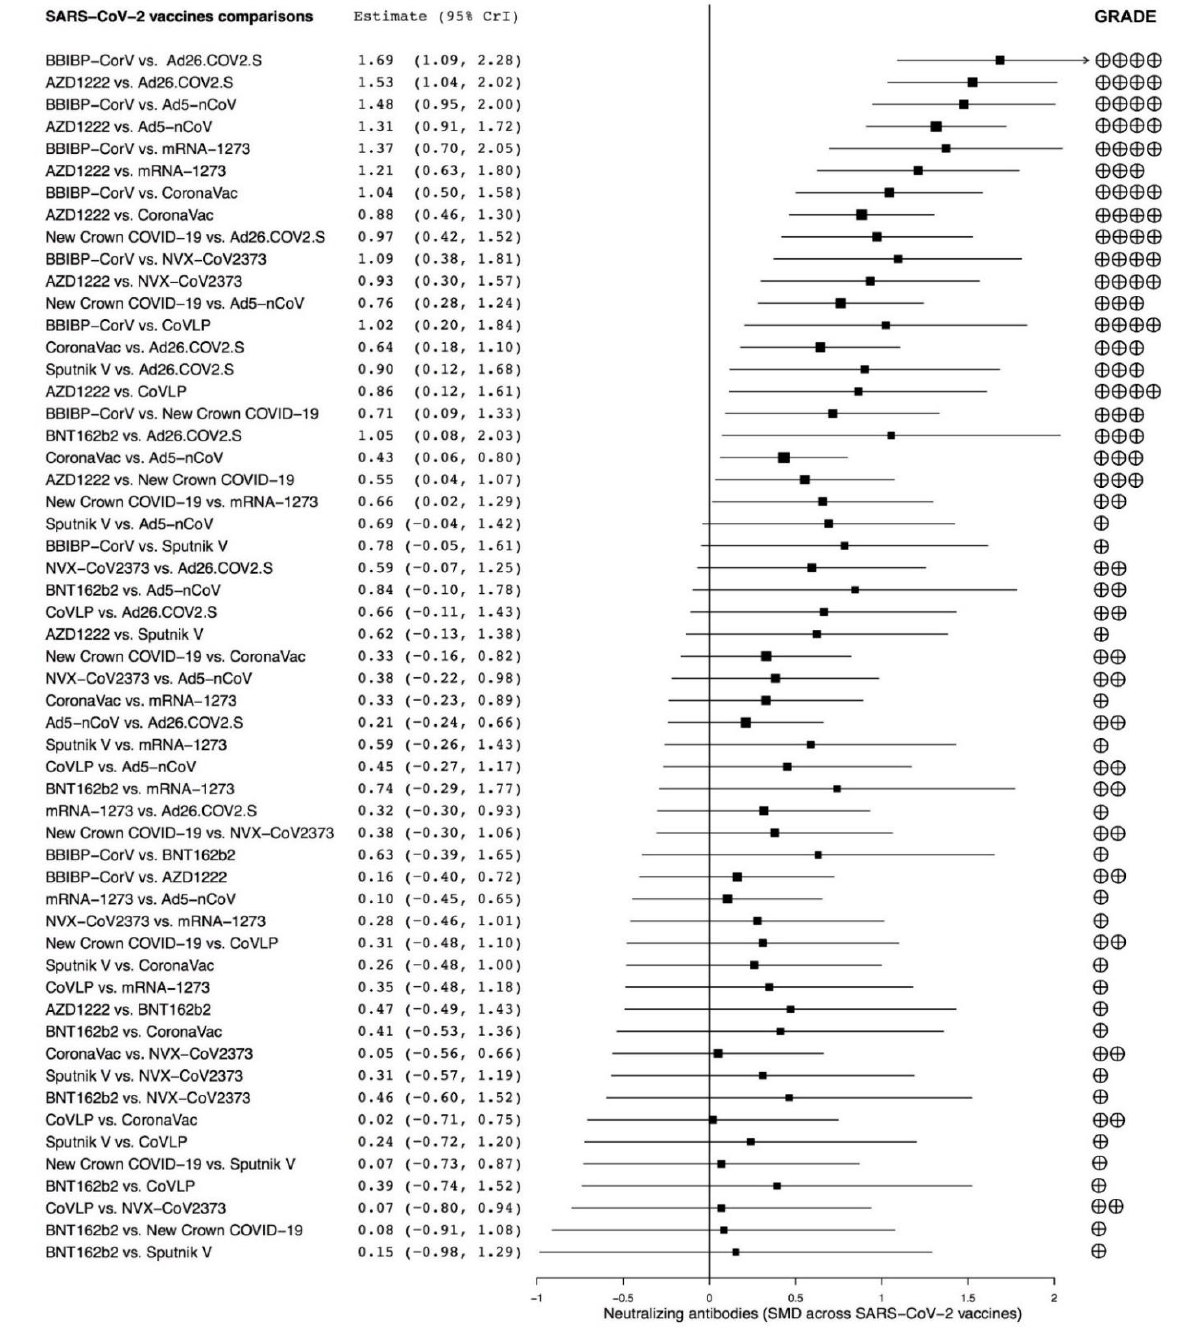
Figure 3. Overall forest plot of the comparisons across different candidate SARS-CoV-2 vaccines on the SMD in peak neutralizing antibodies and quality of evidence assessed via GRADE. SARS-CoV-2 vaccine comparisons have been sorted in agreement with the level of efficacy; 95% CrI: 95% credible interval; GRADE: Grading of Recommendations Assessment, Development, and Evaluation; SARS-CoV-2: severe acute respiratory syndrome coronavirus 2; SMD: standardized mean difference.